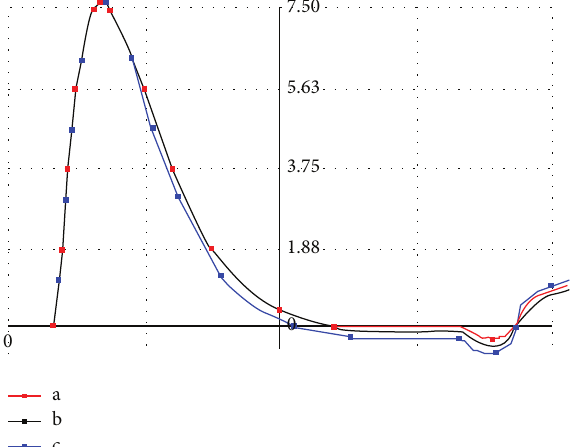
Figure 6: The computed sphere drag coefficient while using grids, shown in Figure